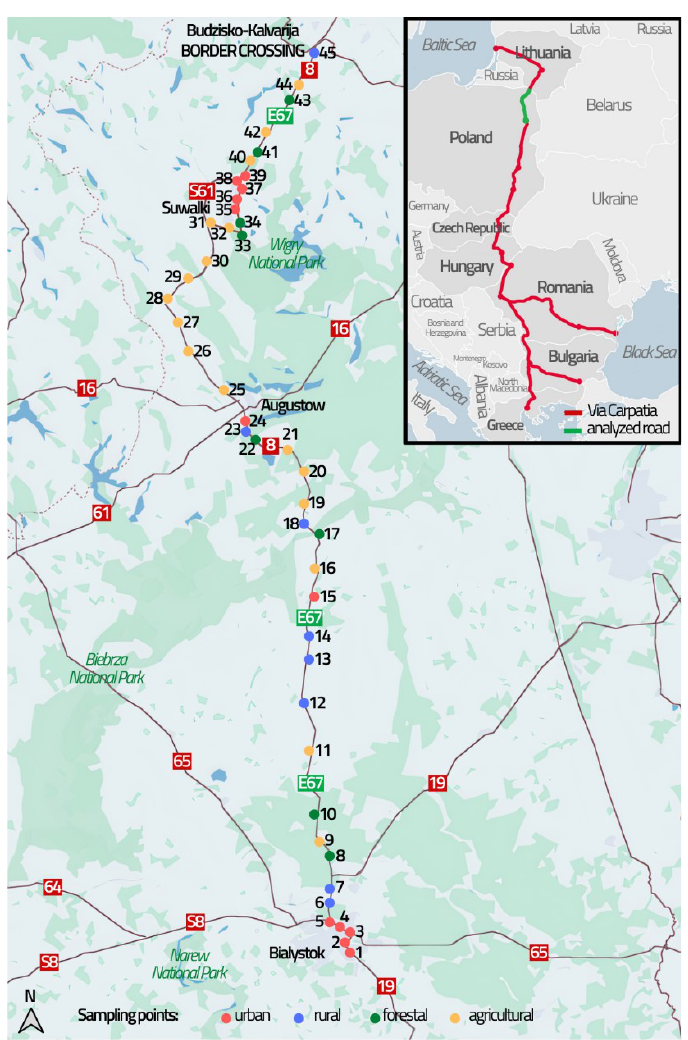
Figure 1. Location of research points on the road from Białystok to Budzisko, northeastern Poland.